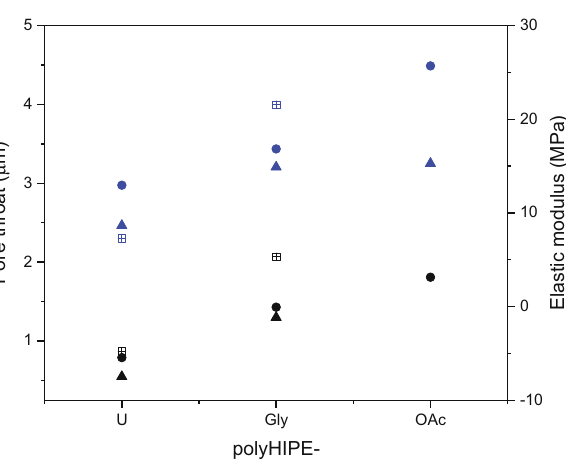
Figure 4: Pore throat size ( black points ) and elastic modulus ( blue points ) for polyHIPEs using: IKA T10 Ultra - Turrax® ( circles ) and IKA T18 Ultra - Turrax® ( triangles ) , to homogenize. Squares represent data taken from Peréz - García et al. ( 25 )